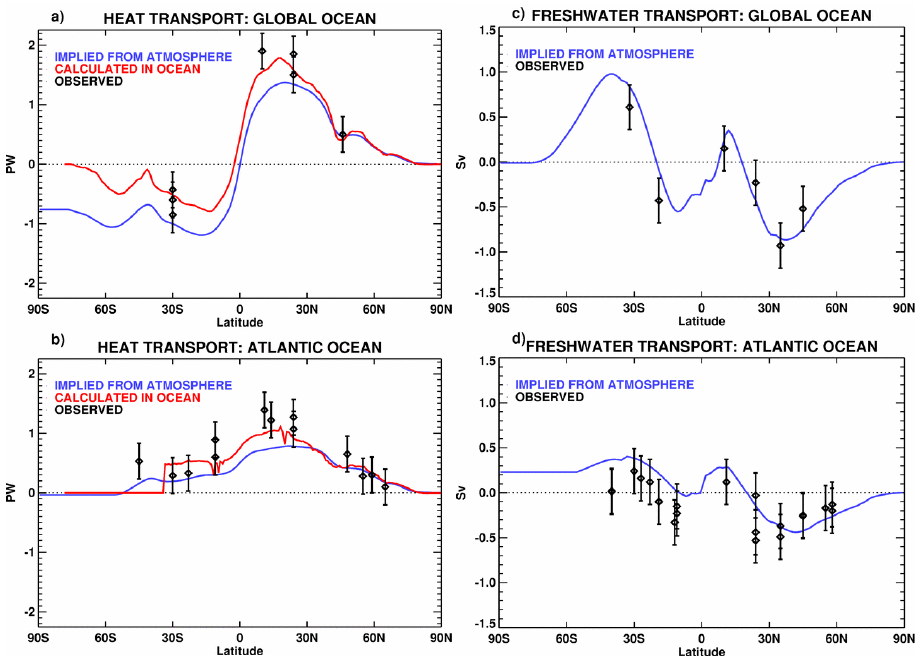
Fig. 12. Integrated northward heat and freshwater ocean transports. (a) Global heat transport, inferred from atmospheric heat fluxes, and calculated within NEMO, compared to observations. (b) Atlantic heat transport, inferred from atmospheric heat fluxes, and calculated within NEMO (including the diffusive component), compared to observations. (c) Global freshwater transport, inferred from atmospheric heat fluxes and compared to observations. (d) Atlantic freshwater transport, inferred from atmospheric heat fluxes and compared to observations.